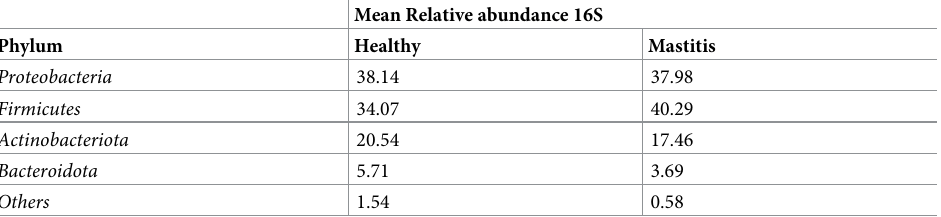
Table 1. Relative abundance of bacterial population in healthy and mastitis camel milk at phylum level for 16S